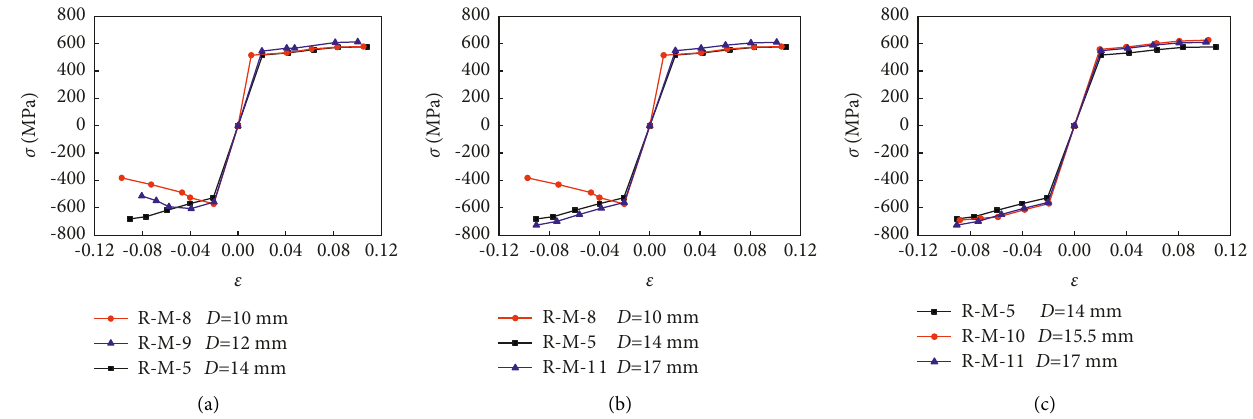
Figure 20: Skeleton curves of material specimens with different diameters in the tensile zone. (a) Specimens with a small diameter in the tension zone. (b) Specimens with large diameter in the tension zone. (c) Specimens with larger diameter in the tension